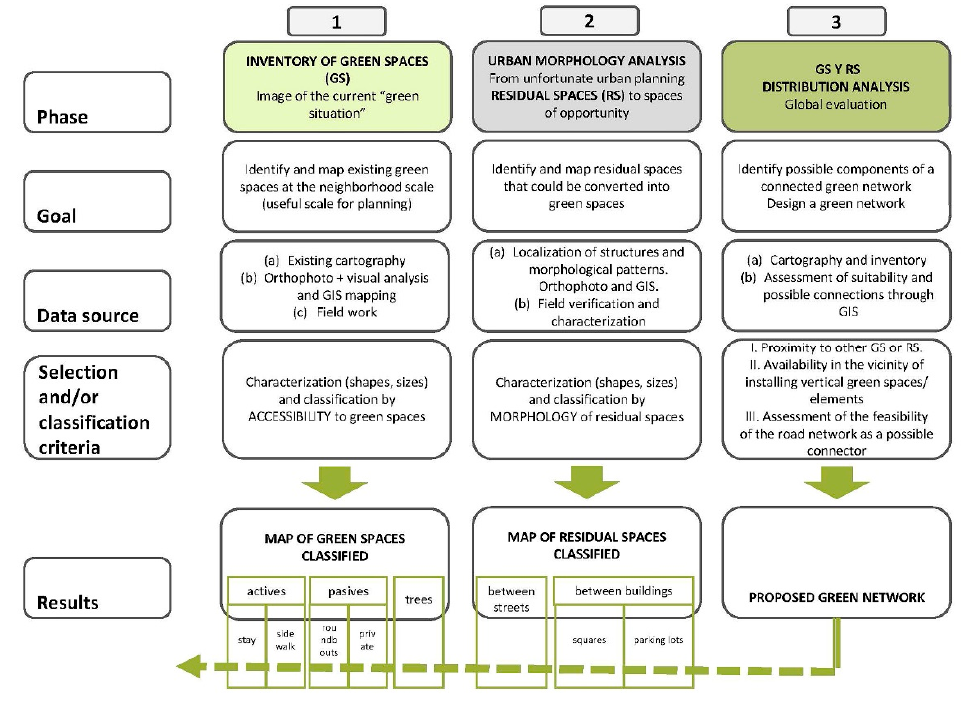
Figure 3. Methodological